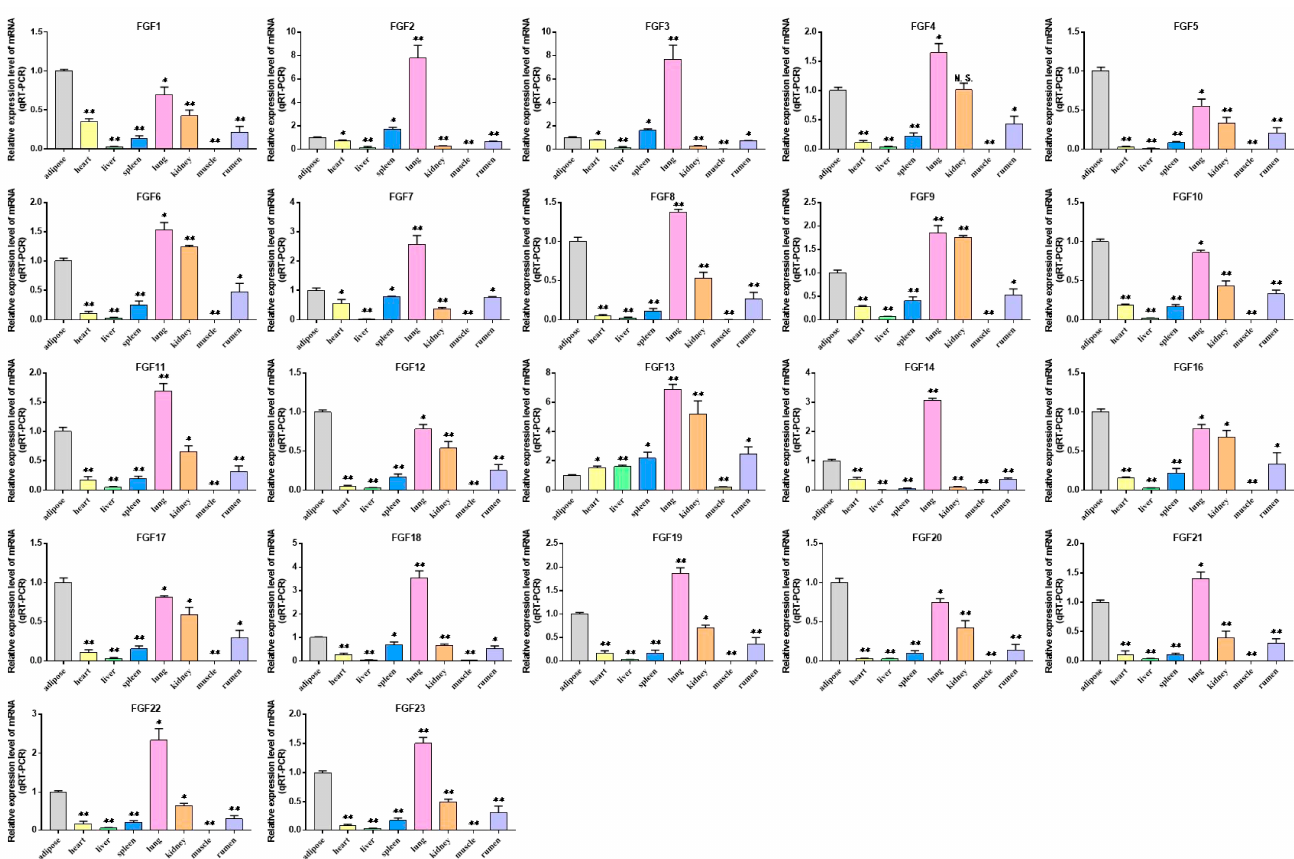
Figure 6. Analysis of the expression of FGF family members in different tissues of cattle. Compared with the control, “*” means a significant difference ( p < 0.05), “**” means an extremely significant difference ( p < 0.01), and “N.S.” indicates a non-significant difference.